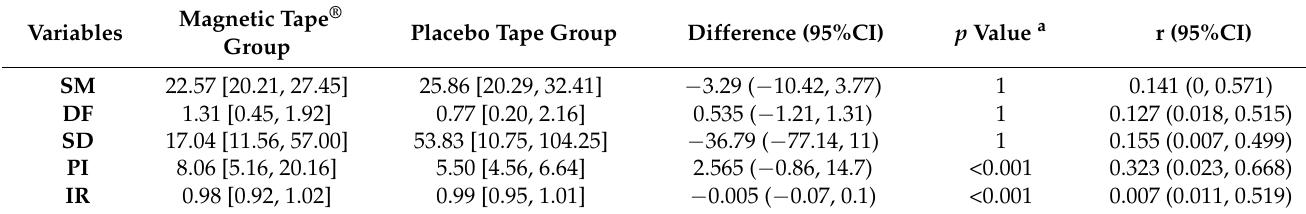
Table 2. Outcome variable results.